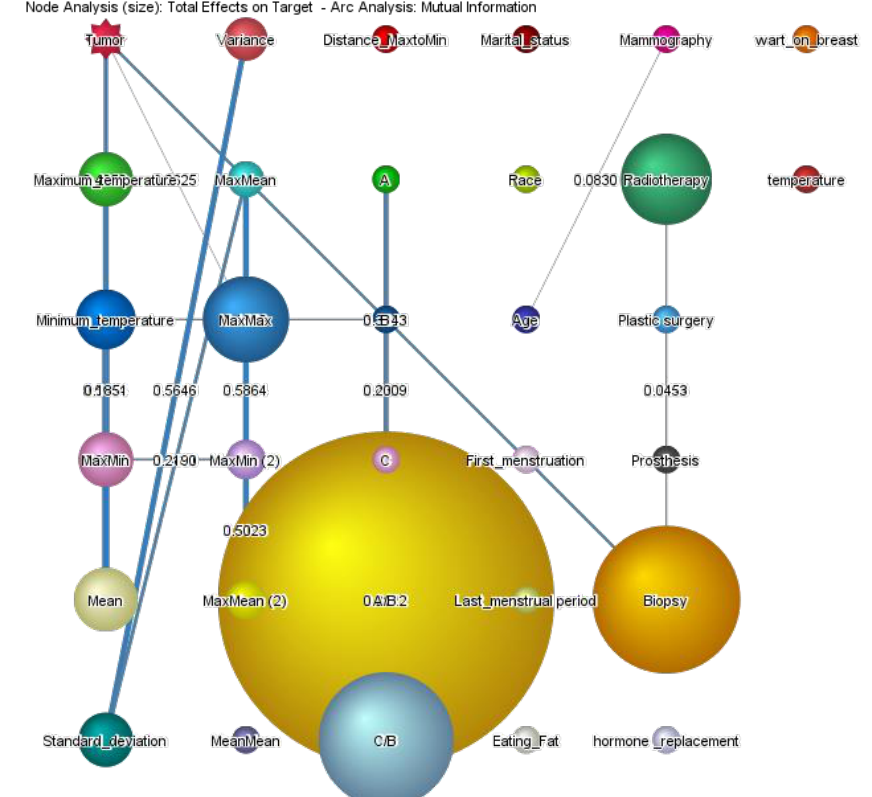
Appl. Sci. 2023 , 13 , 600